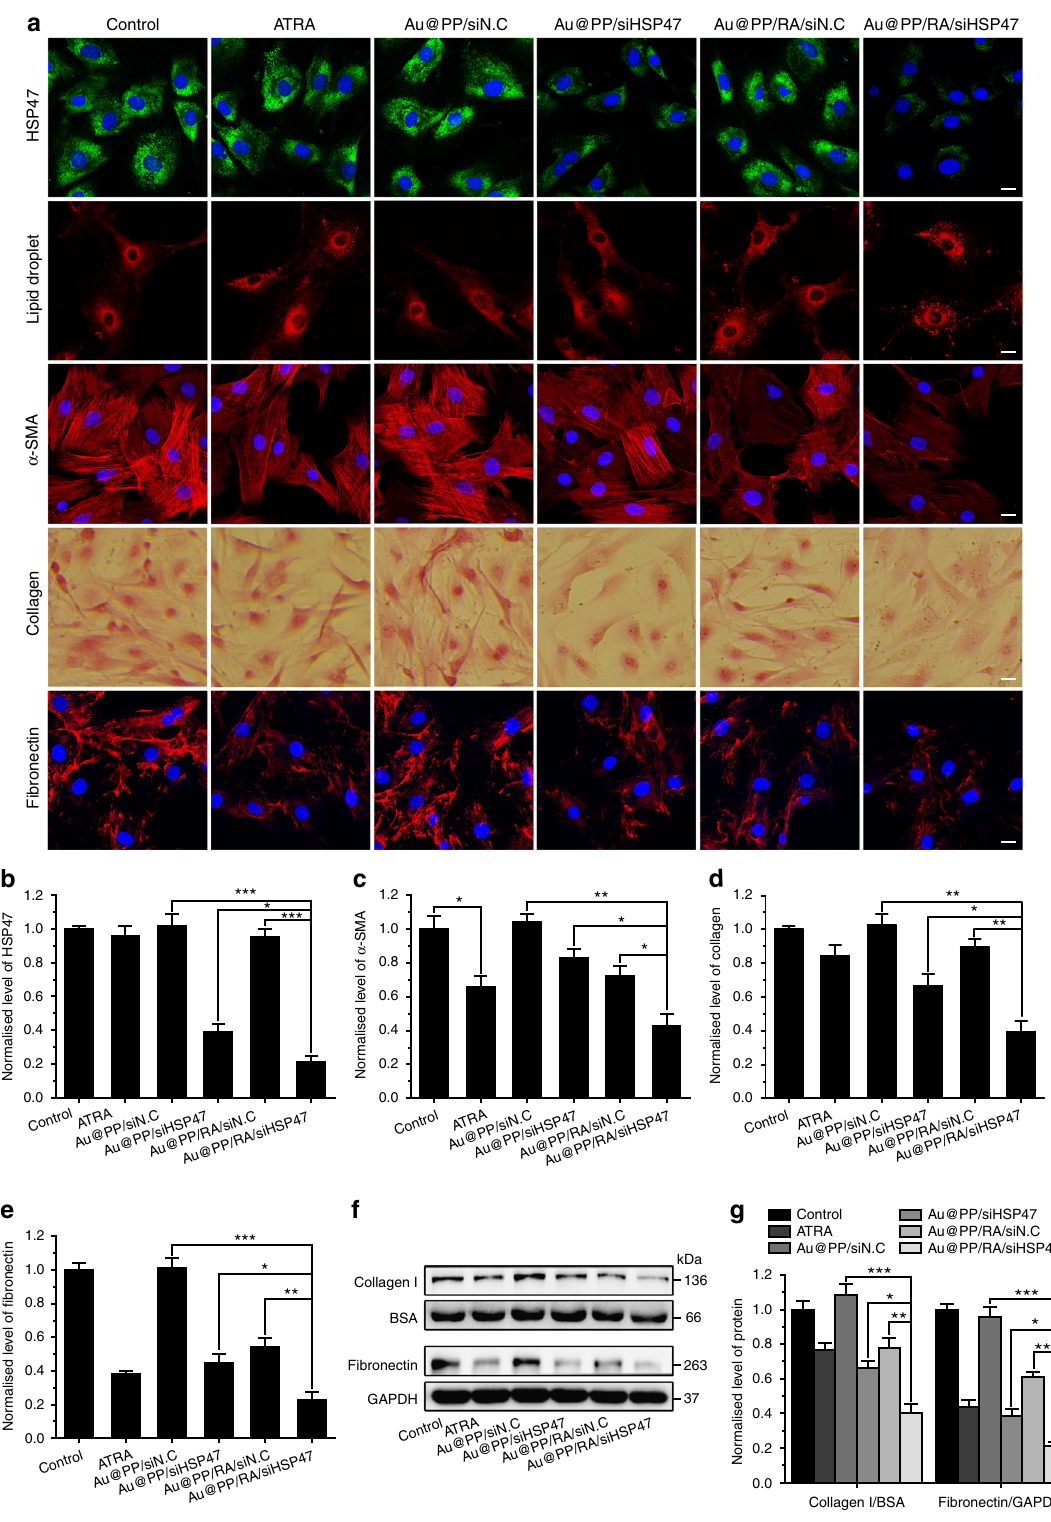
Fig. 4 Reversal of activated PSCs and ECM reduction in vitro. a Immuno fl uorescence (IF) staining of HSP47, nile red staining of lipid droplets, IF staining of α -SMA, Sirius red staining of deposited collagen and IF staining of fi bronectin in PSCs after treatment with the indicated formulations for 48 h at pH 6.5. Scale bars, 20 μ m. b Quanti fi cation of the normalised HSP47 protein expression (using Image J software). c Quanti fi cation of the normalised α -SMA protein expression (using Image J software). d Normalised deposited collagen by measuring extracted Sirius red dye at 540 nm. e Quanti fi cation of the normalised fi bronectin protein expression (using Image J software). f Western blot analysis of secreted collagen I in the PSCs culture supernatant and fi bronectin in whole cell lysates after treatment with the indicated formulations for 48 h at pH 6.5. g Quantitative analysis of the normalised fi bronectin and collagen I protein expression (using Image J software). The data are shown as the mean ± s.d. ( n = 3). * p < 0.05, ** p < 0.01, *** p < 0.001 (Student ’ s t